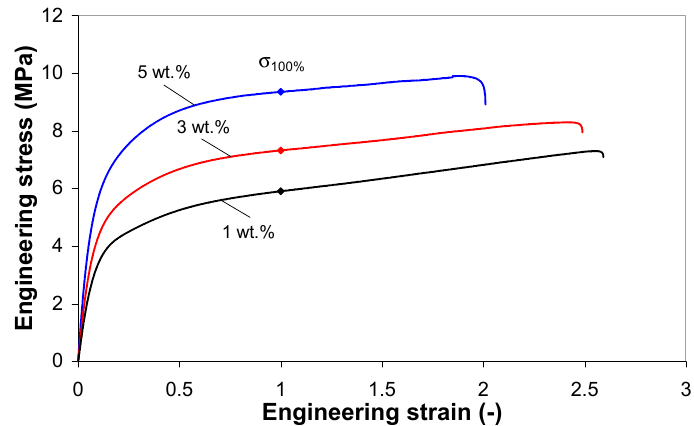
Figure 10. Stress-strain curves for EVA / MWCNT composites at 50 mm / min. Figure 10. Stress - strain curves for EVA/MWCNT composites at 50 mm/min. Figure 10. Stress - strain curves for EVA/MWCNT composites at 50 mm/min.